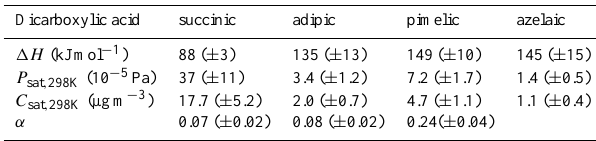
Table 2. Thermodynamic and kinetic properties of the dicarboxylic acids used in this study. P sat , 298K and 1H values are obtained from Saleh et al. (2008, 2009, 2010) and α values are obtained from Saleh et al.